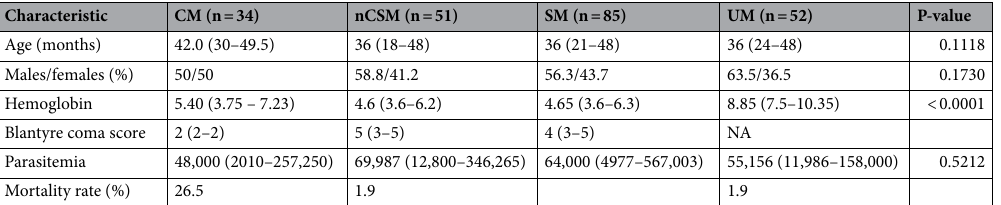
Table 1. Characteristics of study participants 1 . SM all severe malaria cases, i.e., CM and nCSM; CM cerebral malaria, nCSM non-cerebral severe malaria, UM uncomplicated malaria. Hemoglobin (g/dL); Parasitemia (parasites/µl). Values are medians (25th; 75th percentile). Kruskal–Wallis’s test was used to compare the three groups (CM, nCSM and